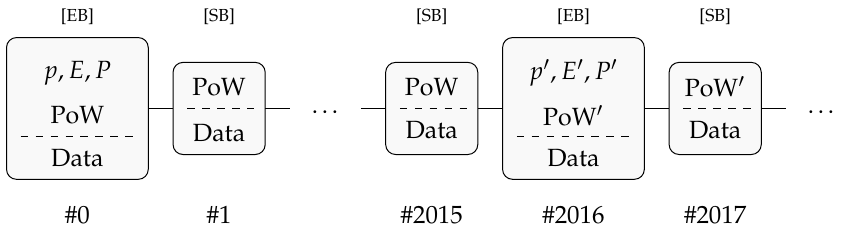
Figure 1. Sample blockchain